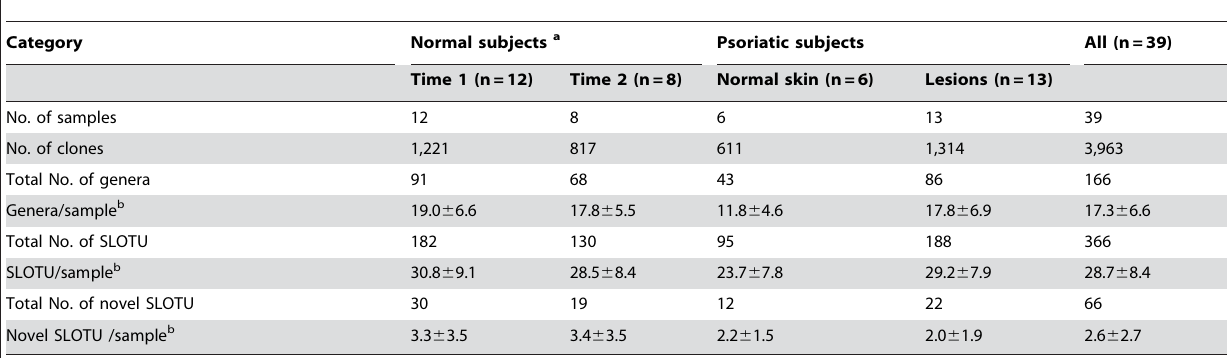
Table 2. Number of genera and SLOTU detected in 39 human skin samples